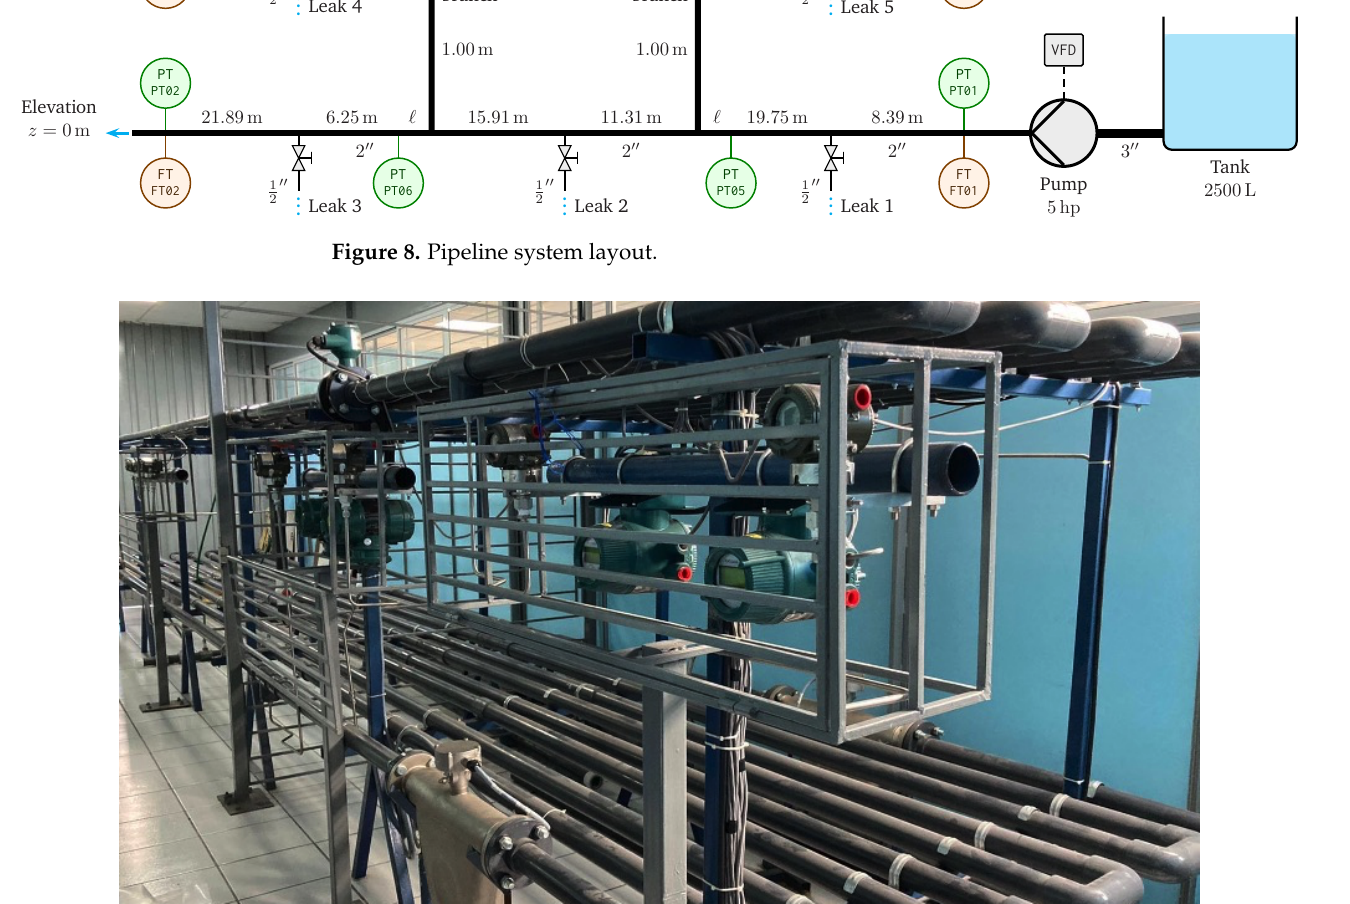
Figure 9. Pipeline